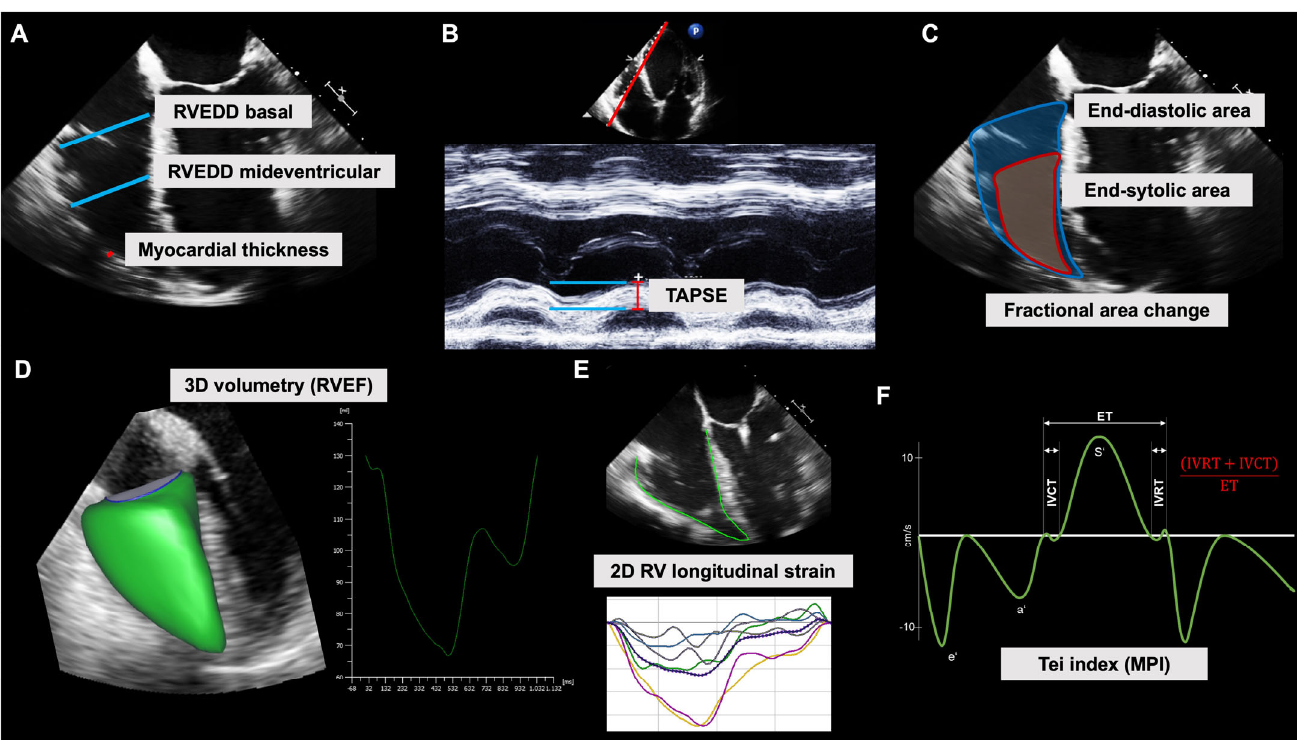
Figure 3. Analysis of right ventricular function. ( A ) Measurement of the enddiastolic diameter of the right ventricular (RVEDD) and the myocardial thickness of the free wall in the four-chamber mid-esophageal view provides a rapid analysis of the dimensions of the right ventricular. ( B ) Tricuspid annular plane systolic excursion (TAPSE, mm) using M-mode in apical four-chamber view reflects longitudinal right ventricular systolic function. ( C ) The relative change between the end-diastolic and end-systolic endocardial right ventricular area is called the fractional area change (FAC). FAC can be obtained in four-chamber transthoracic or transesophageal views and is a measure of systolic function. ( D ) Three-dimensional acquisition of the whole right ventricle and speckle-tracking-based analysis yields RV volumes, stroke volume, and ejection fraction (RVEF), avoiding geometrical assumptions and confounding 2D artifacts. ( E ) Strain analysis using speckle-tracking allows for the quantification of myocardial deformation, e.g., 2D RV longitudinal strain of the septal and free wall. ( F ) The Tei index (or myocardial performance index, MPI) is derived from isovolumetric relaxation time (IVRT), isovolumetric contraction time (IVCT), and ejection time (ET). This measure of global right ventricular function is usually calculated automatically after the manual definition of IVRT, IVCT, and ET in the tissue doppler profile of the basal right ventricular free